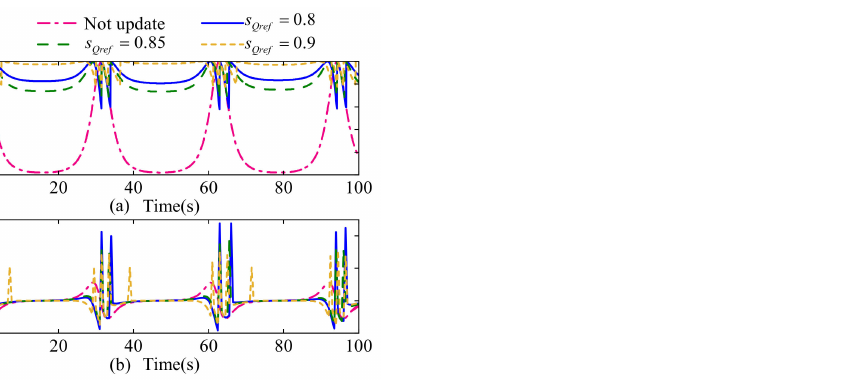
Figure 22. Cosine similarity of the weight coefficient matrix Q and its change rate under the sine input: ( a ) cosine similarity; ( b ) cosine similarity rate.